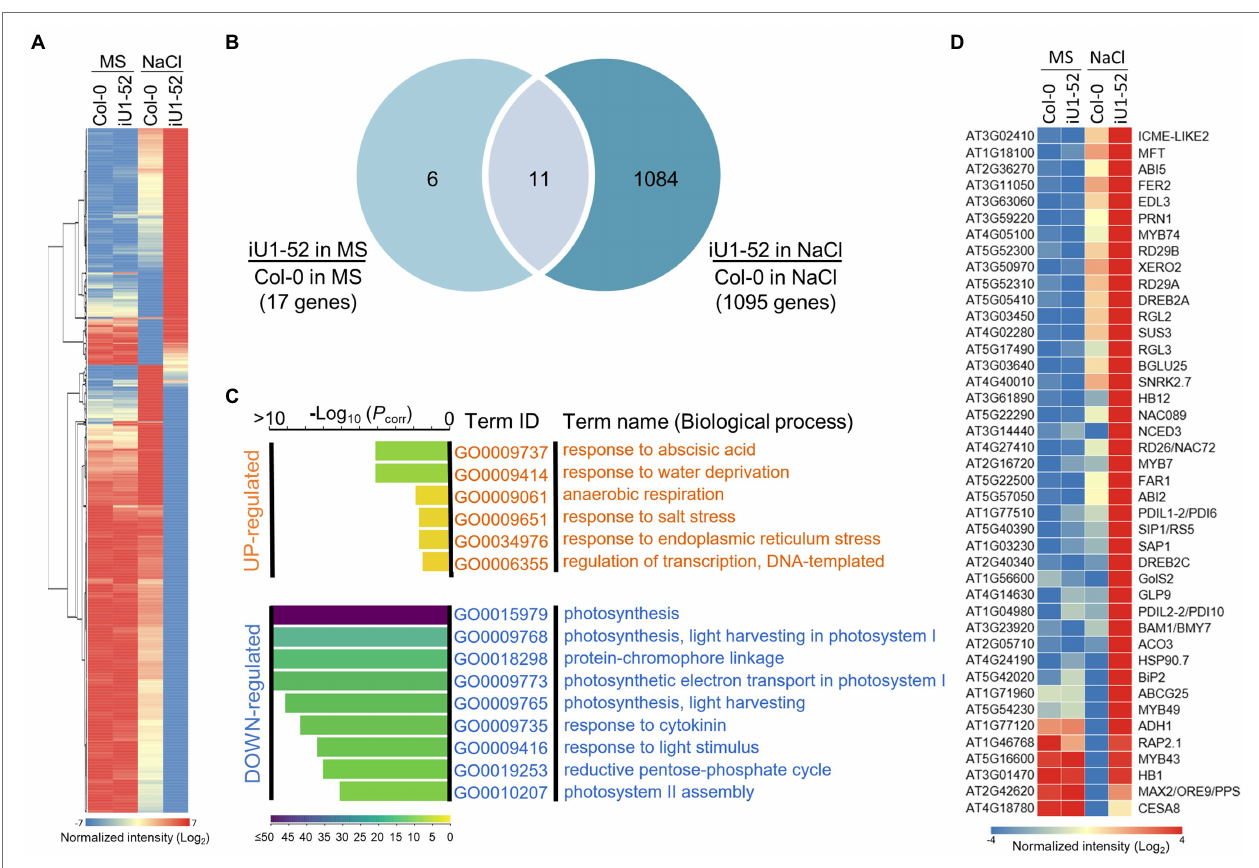
FIGURE 8 | GlcNA.UT -mediated gene expression profiles. (A) Heatmap of differentially expressed gene (DEG) profile. Total RNA was derived from seedlings grown on agar plates supplemented with or without 200 mM NaCl for 14 days. A total of 1,101 DEG genes derived from the microarray assay were used in this analysis. (B) Venn diagram indicating the overlap of DEG genes between salt and salt-free treatments. (C) Gene ontology (GO) analysis of biological processes. (D) Heatmap showing DEG genes involved in ABA, water deprivation, salt and ER stress responses. For the microarray assay, three biological replicates were performed, and the raw data are available in the Gene Expression Omnibus (GEO) database, with accession No.